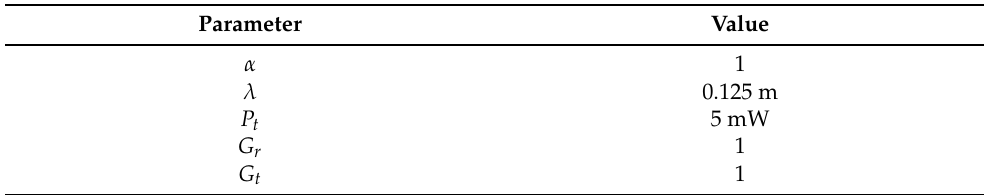
Table 1. Parameter values of the experiments. Parameter